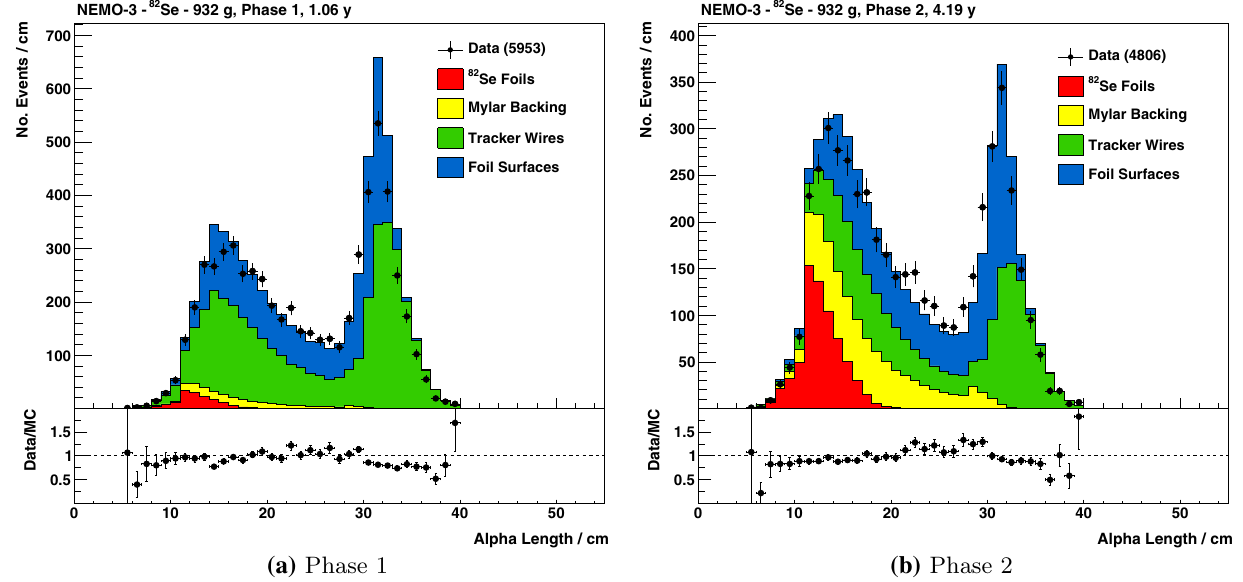
Fig. 3 Distributions of the length of α -particle tracks from the 1e1 α N γ channel, which contains events with one electron track and one delayed α -particle track, with no constraints on the number of γ - rays present. The length is measured as the distance from the electron vertex on the foil to the furthest hit in the α -particle track. a Shows data from phase 1, which had a higher radon level in the tracker and b shows thesamedistributionforphase2data.Inthetoppanels,dataareoverlaid